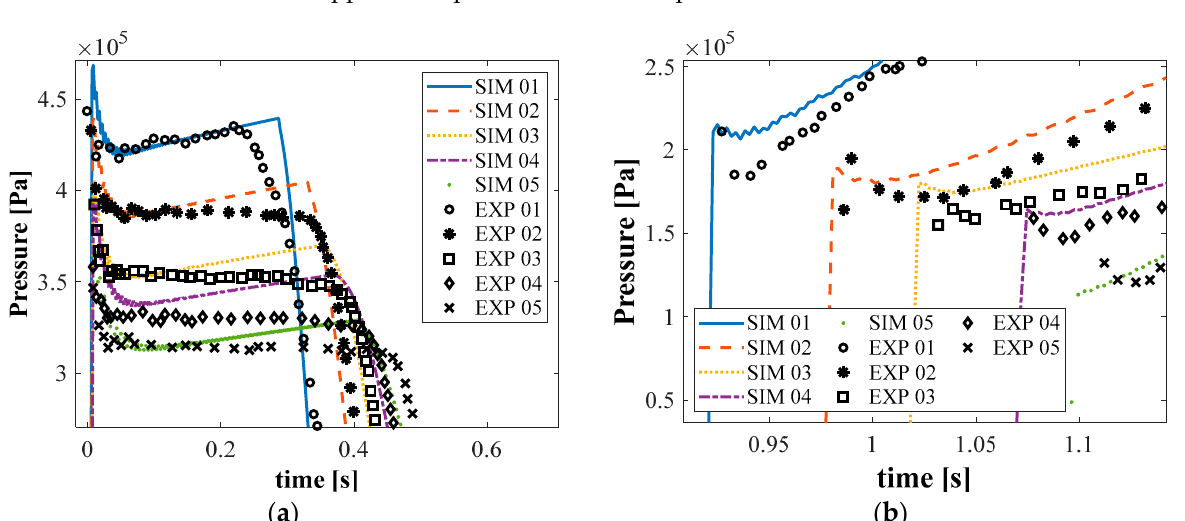
Figure 5. Enlargement of ( a ) top of first amplitude and ( b ) early stage of second amplitude.